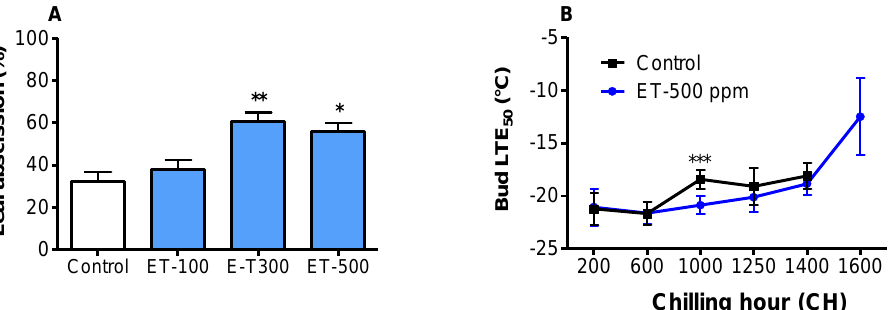
Figure 2. Effects of ethephon (ET) on leaf abscission and cold hardiness of ‘Redhaven’. ( A ) Leaf abscission 7 days after ethephon applications. Bars represent the mean ± SE of three biological replicates (10 branches/replicate); ( B ) LTE 50 (temperature at which 50% of the buds are killed) of flower buds during endodormancy and ecodormancy. Each point represents the mean LTE 50 ± SE of 12–18 individual buds. Asterisks *, **, and *** indicate significance at p < 0.05, 0.01, and 0.001, respectively. CH accumulation corresponds to calendar dates of 15 November and 11 December of 2019, and 5 January, 6 February, 14 February, and 4 March of 2020, respectively.